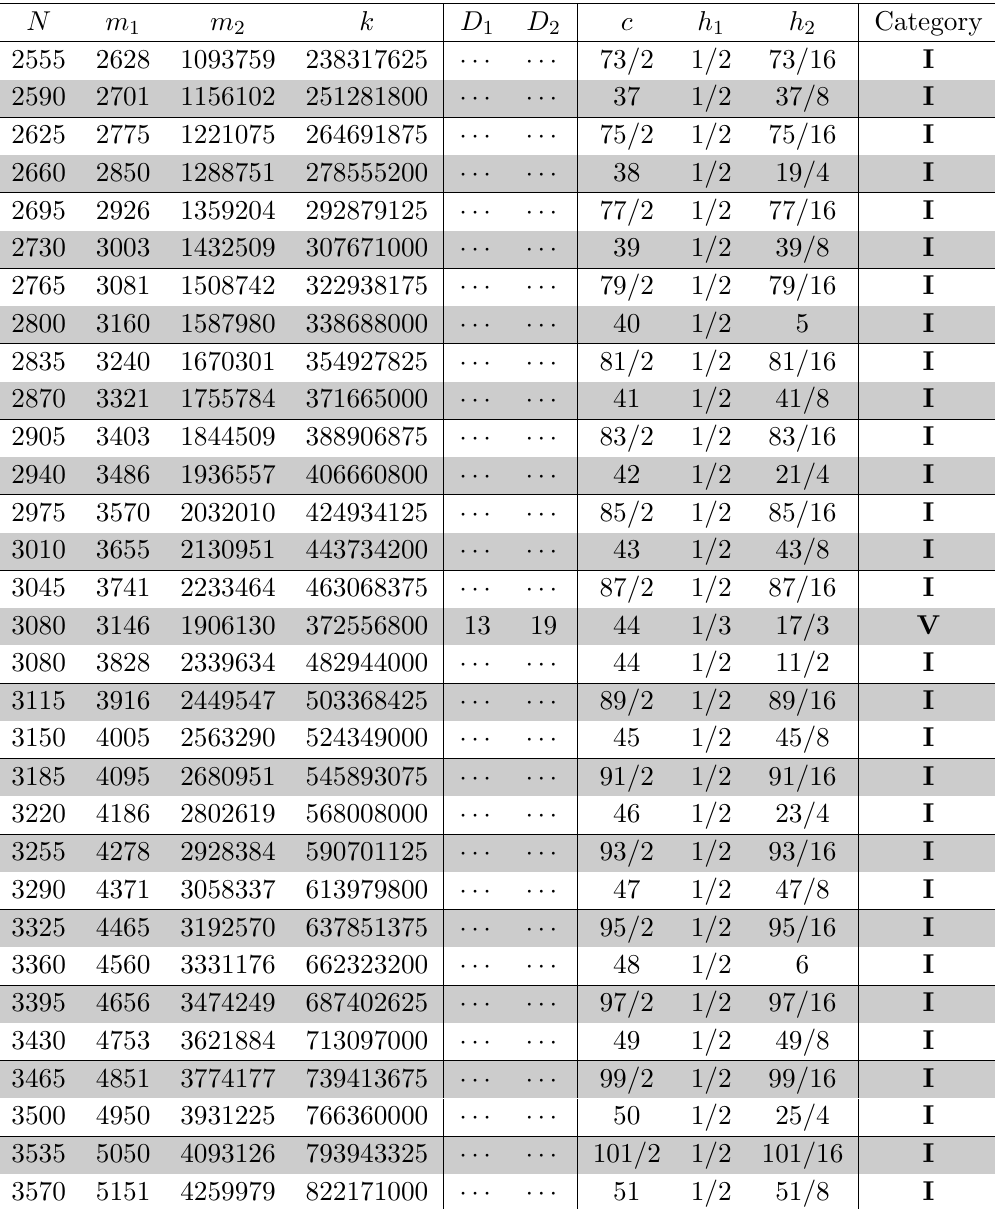
Table 17 . Solutions to the [ 3 , 0 ] MLDE with 36 < c ≤ 51